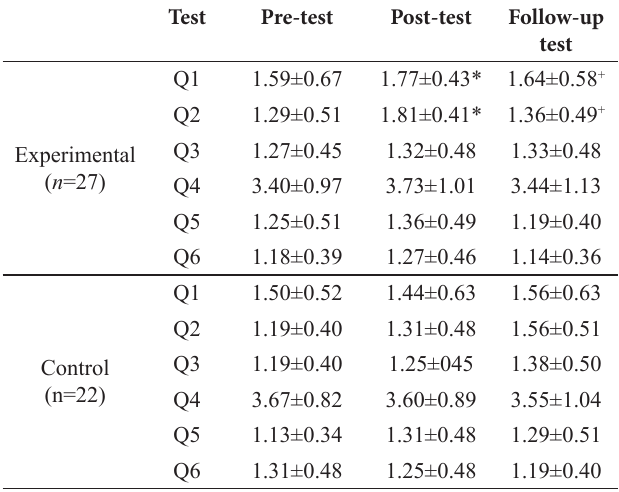
Table 4. Level of school students’ perception of